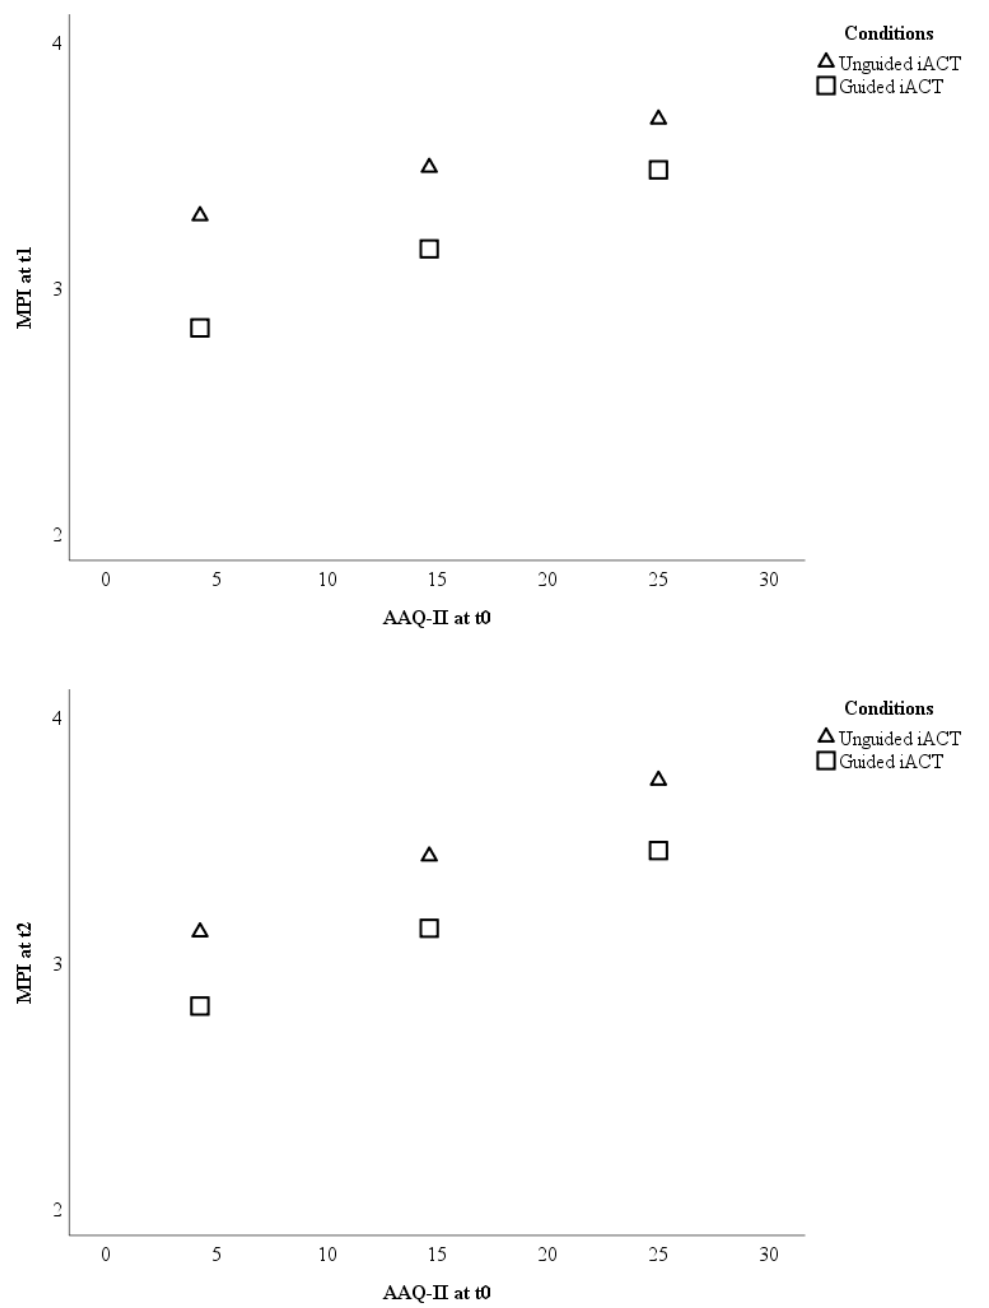
Figure 3. Visualizations of the results testing baseline psychological inflexibility as a moderator of the treatment outcome pain interference between unguided and guided Internet-based ACT. The outcome ( Y -axis) is displayed for three different levels (sample mean ± 1 standard deviation) of psychological inflexibility ( X -axis). Note: AAQ-II = Acceptance and Action Questionnaire; iACT = Internet-based Acceptance and Commitment Therapy; MPI = Pain interference scale of the Multidimensional Pain Inventory; t0 = baseline; t1 = 9-weeks after randomization; t2 = 6-months after